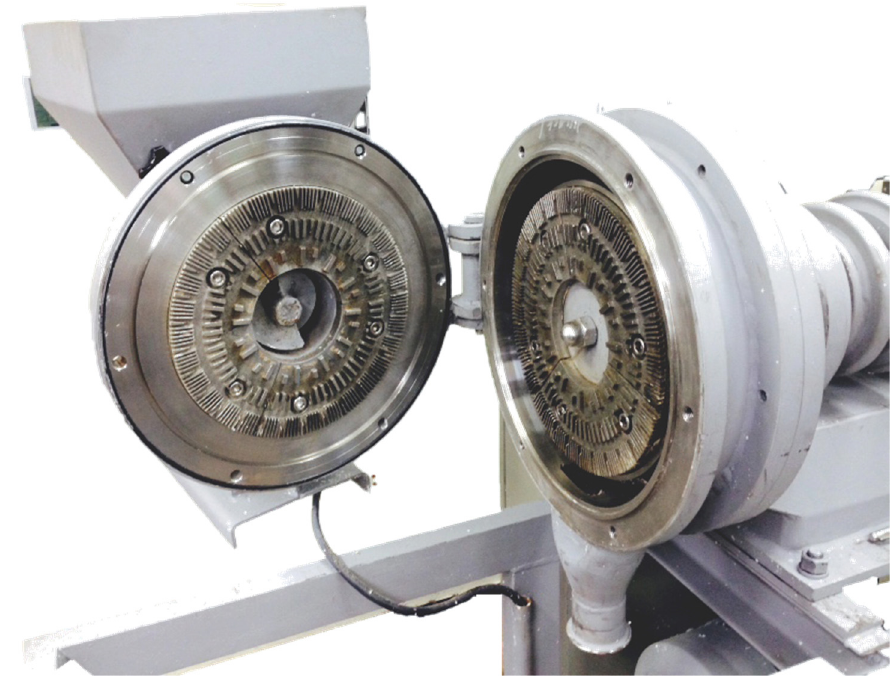
Figure 3. Single disk re fi ner fi tt ed with TMP plates.